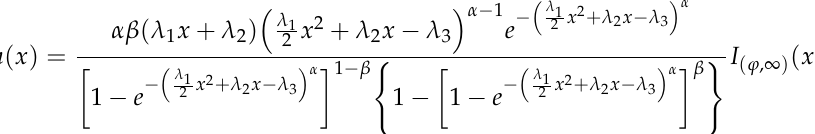
+ 2 λ > 1 or α = β = 1, λ 1 λ 3 ; ( b ) αβ 2